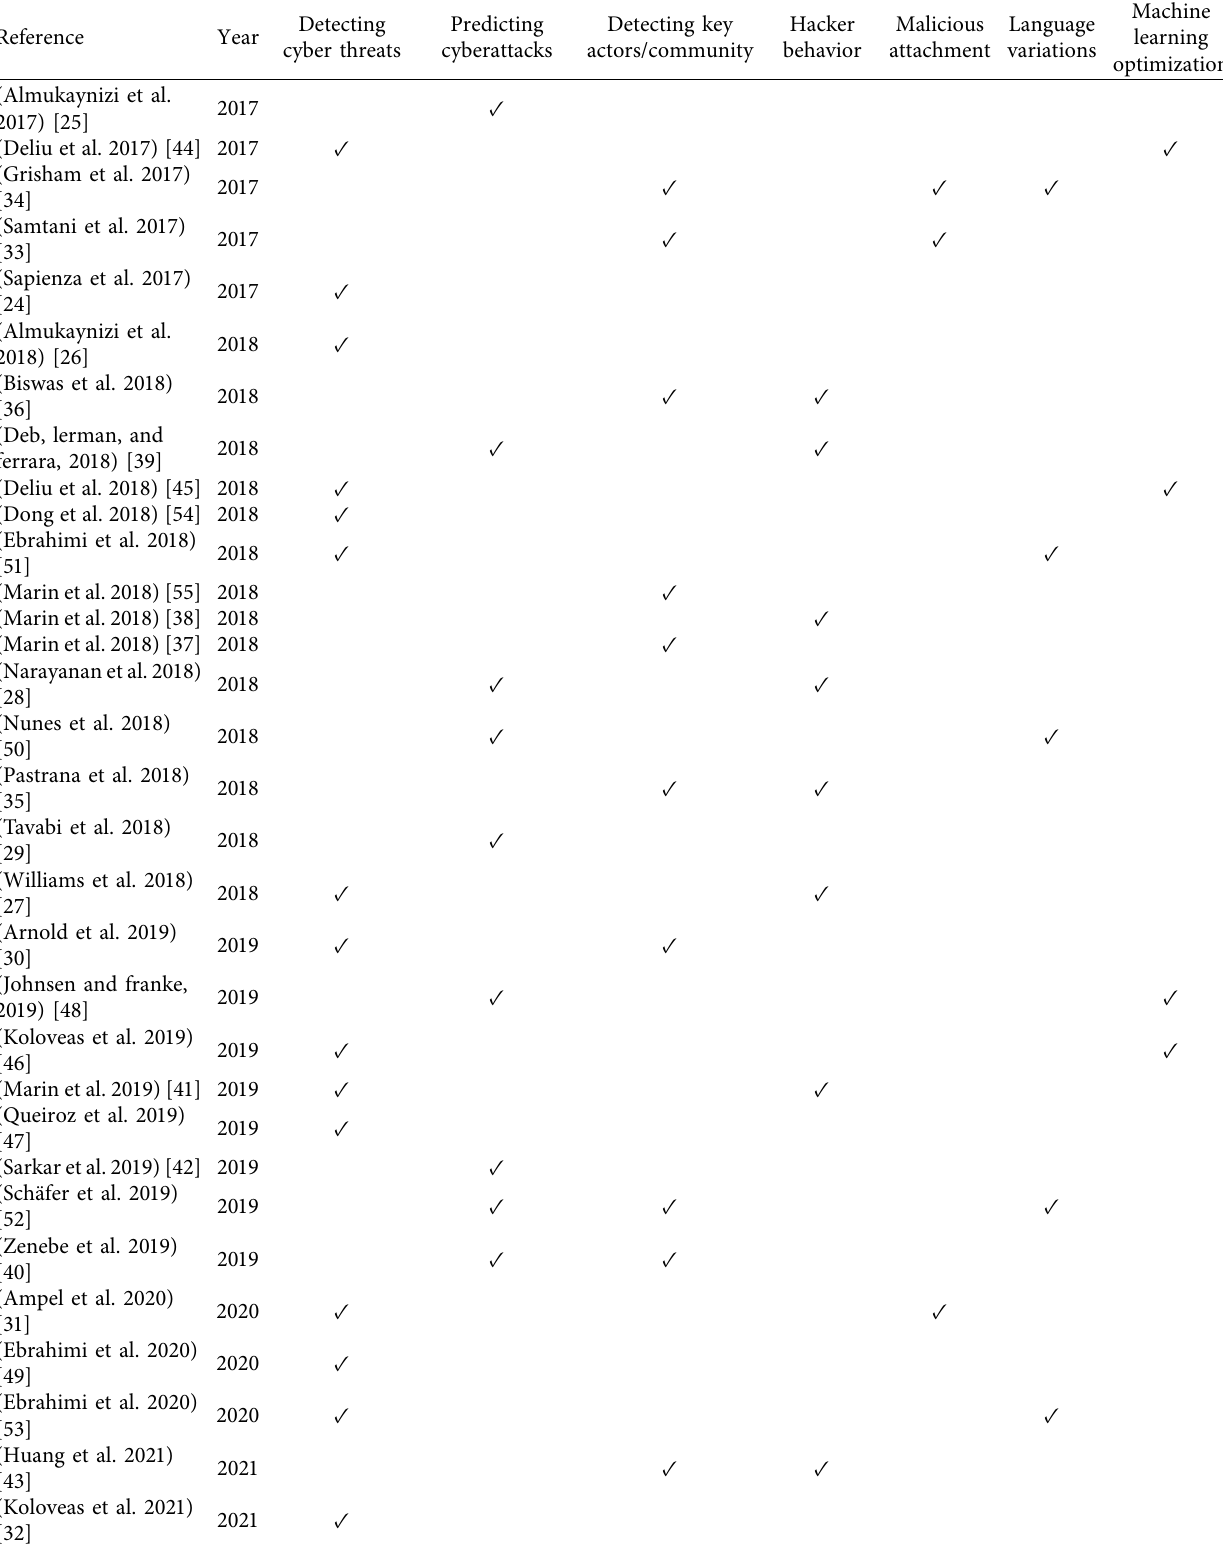
Table 2: Major topics covered by the reviewed literature (sorted by